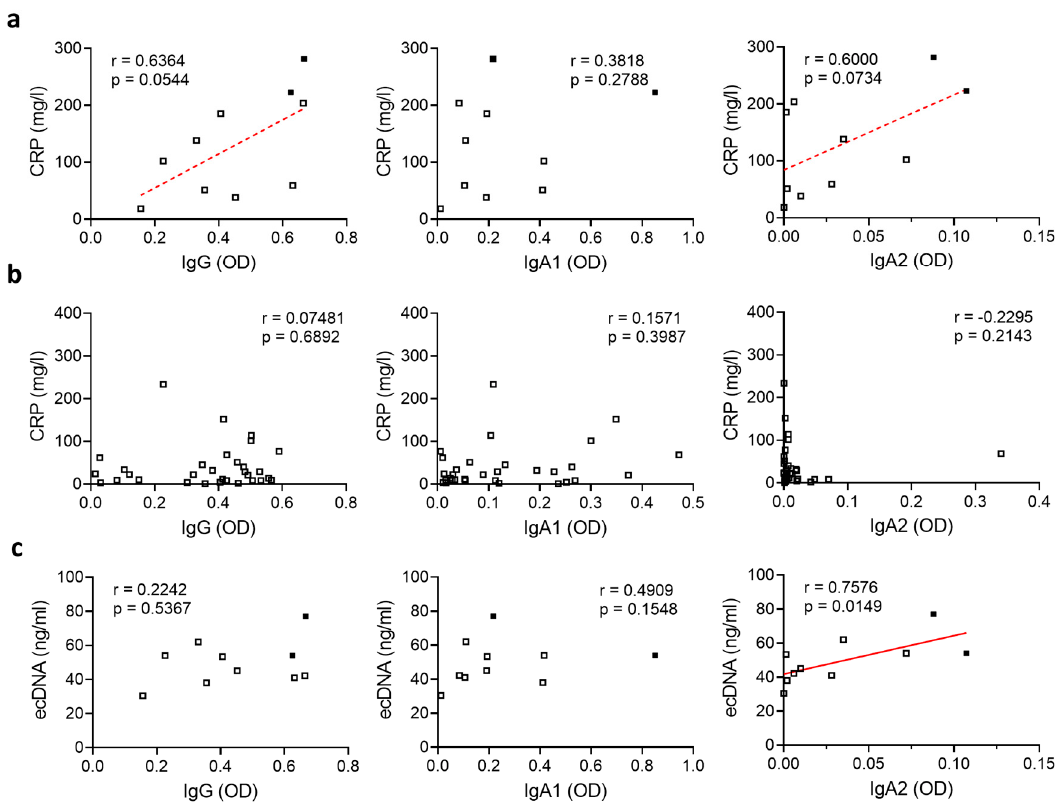
Figure 2. SARS-CoV-2-specific IgA2 levels correlate with ecDNA in severely diseased patients. ( a , b ) Correlation of levels of IgG, IgA1 and IgA2 directed against S1 + S2 protein of SARS-CoV-2 with CRP in the plasma of SARS-CoV-2-infected patients with ( a ) severe disease (N = 10) or ( b ) moderate disease (N = 31). Filled squares represent patients who died. ( c ) Correlation of levels of IgG, IgA1 and IgA2 directed against S1 + S2 protein of SARS-CoV-2 in the plasma of SARS-CoV-2-infected subjects with severe disease (N = 10) with the amount of ecDNA. Filled squares represent patients who died. Significance was tested with Spearman’s correlation coefficient. p < 0.05 was considered significant. Data are presented as scatter plots.